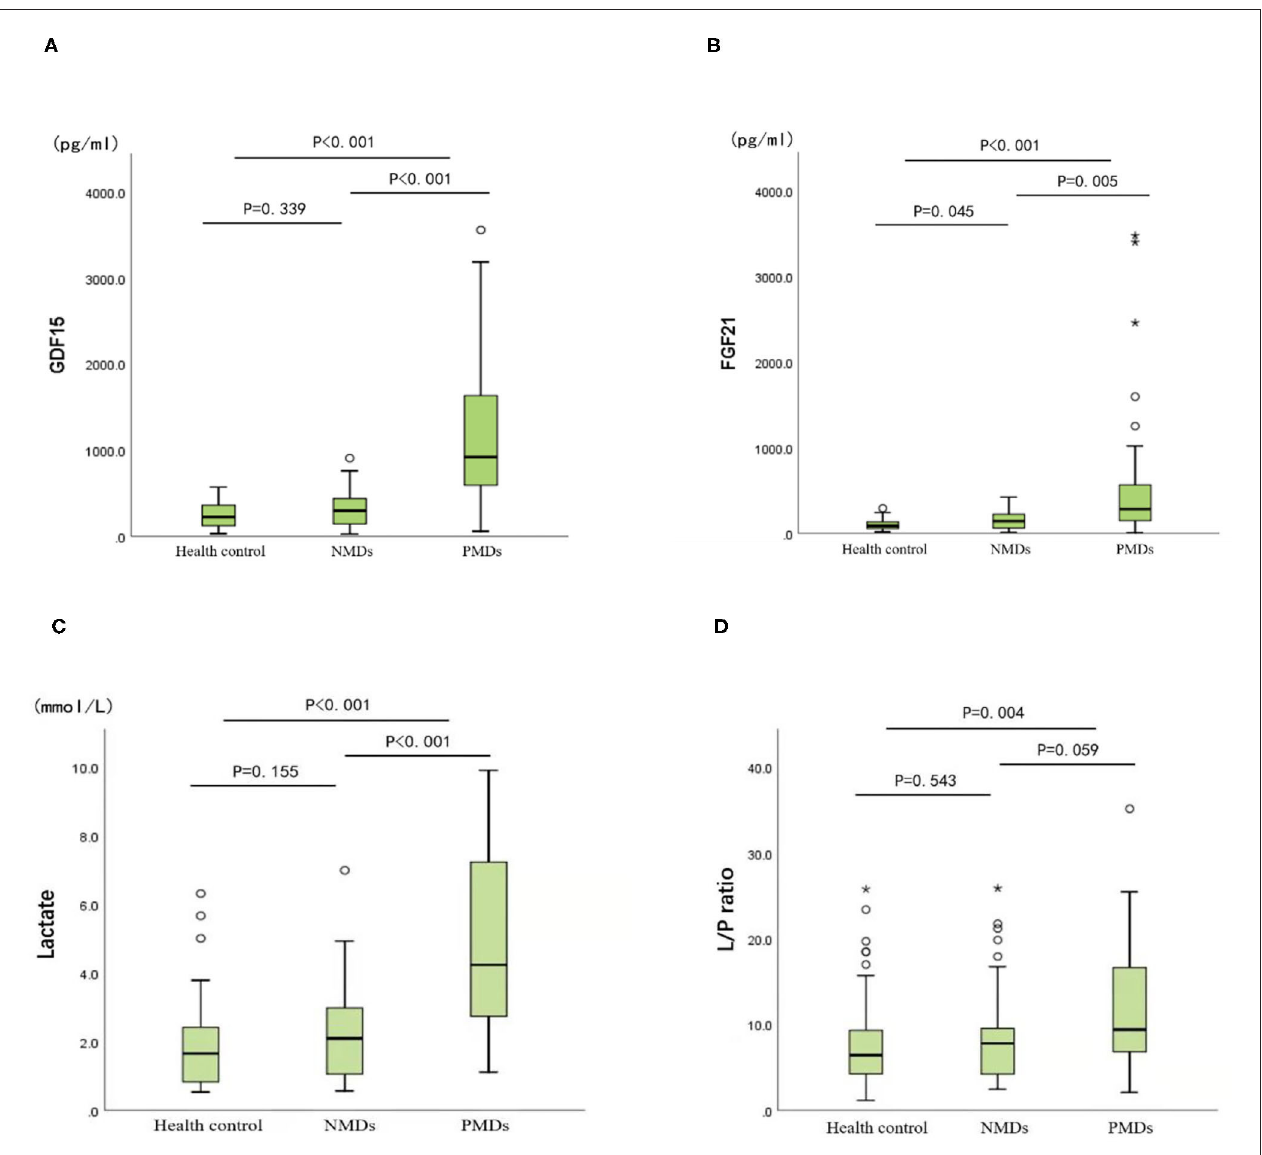
FIGURE 1 | Biomarker concentrations in the healthy controls, mitochondrial diseases, and other neuromuscular diseases. (A) GDF15. (B) FGF21. (C) Lactate. (D) Lactate/pyruvate. Mann-Whitney U non-parametric test is performed for comparison between groups. * P < 0.05, ** P < 0.01.